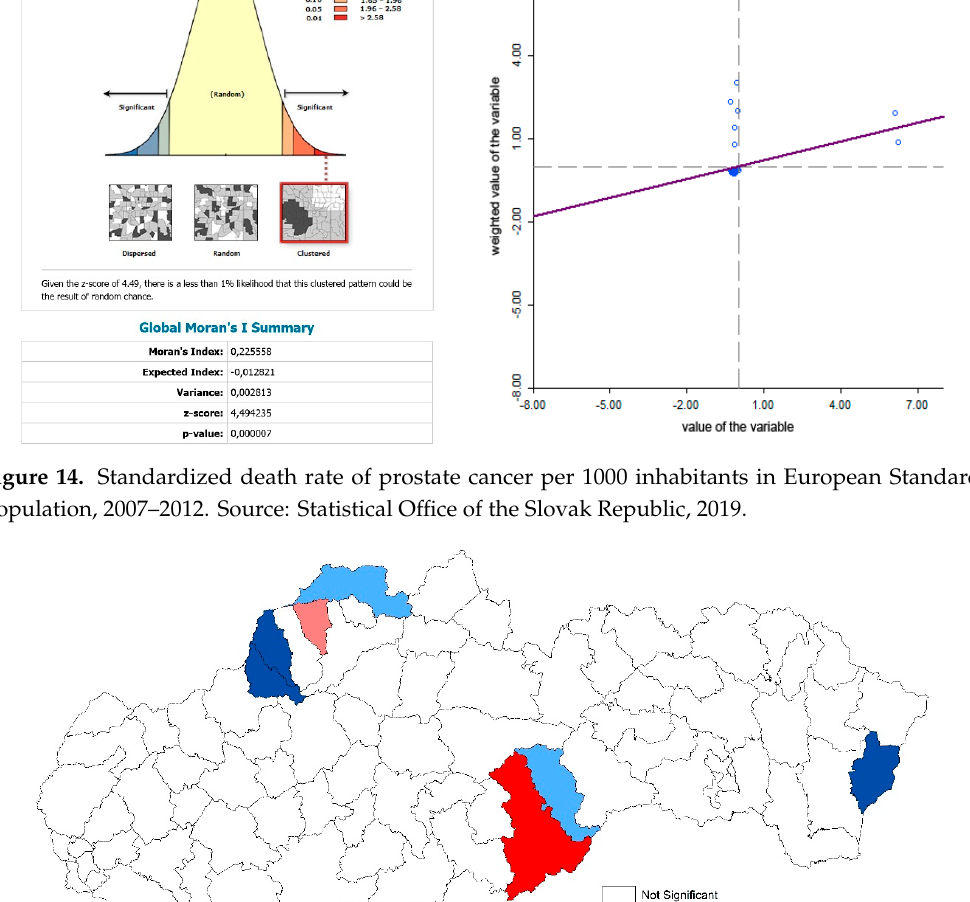
Figure 16 . Standardized death rate of prostate cancer per 1000 inhabitants of European Standard Population, 2013–2018. Source: Statistical Office of the Slovak Republic, 2019. 3.2.2. Standardized Death Rate of Prostate Cancer The prostate cancer standardized death rate in men in Slovakia is characterized by a varied intensity, as well as spatial disparities. The distribution of the standardized death rate values varies in Slovakia. In the period 2001–2006, four regions were formed with the highest prostate cancer death rate (more than 0.271 per 1000 inhabitants of the European Standard Population). Altogether, 23 districts were identified in this category (Figure 17). The following examined period is characterized by the fact that most districts with the highest death rates are located in the north of Slovakia (Figure 18). This group includes districts Košice III, Poltár, Bánovce nad Bebravou, Hlohovec, Senec, and Bratislava IV. Figure 19 summarizes the prostate cancer standardized death rates in the period 2013– 2018. This period is characterized by an overall decrease of the standardized death rate in most Slovak districts.